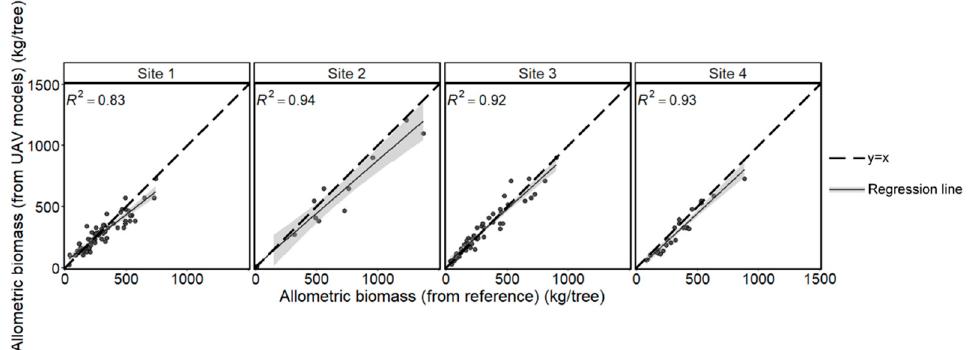
Figure A8. Site-specific AGB values obtained from allometric equations on variables measured by UAV (vertical axis) and reference values (horizontal axis) in coppice stands in Zone 2.